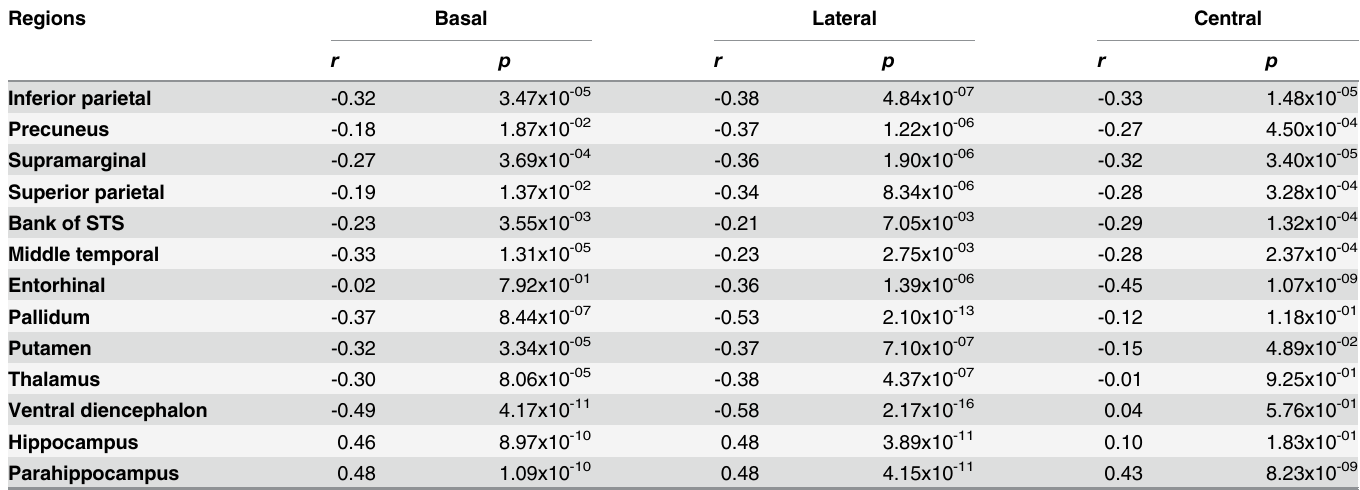
Table 3. Correlation of connectivity to target regions with age per